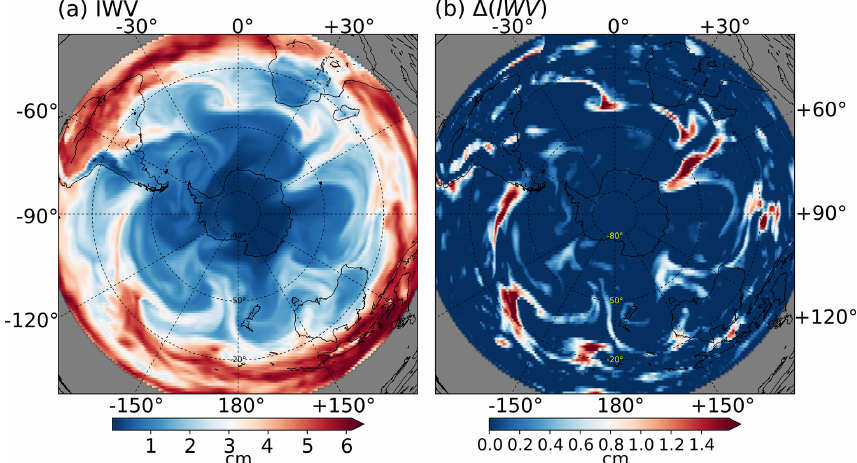
Figure 11. (a) IWV in the Southern Hemisphere on 19 May 2009 at 00:00UTC, in cm. (b) IWV anomalies in cm, obtained using a two-step THR, which uses a structuring element E with size t = 4d, s = 6